Question: Describe this figure in one sentence.
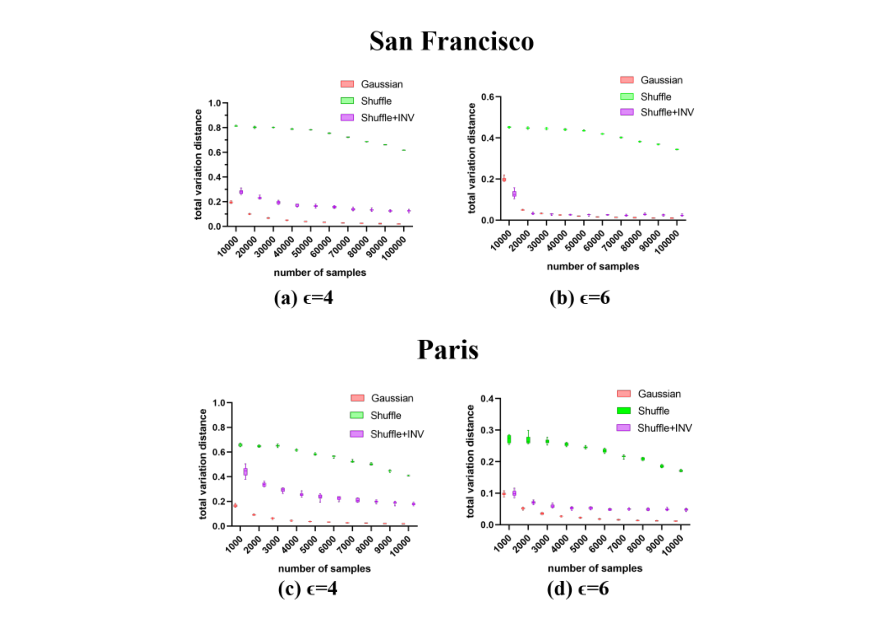
Answer: Illustrating the comparison of community level utilities between Gaussian, shuffle and shuffle+INV for varying n and ϵ in San Francisco and Paris dataset